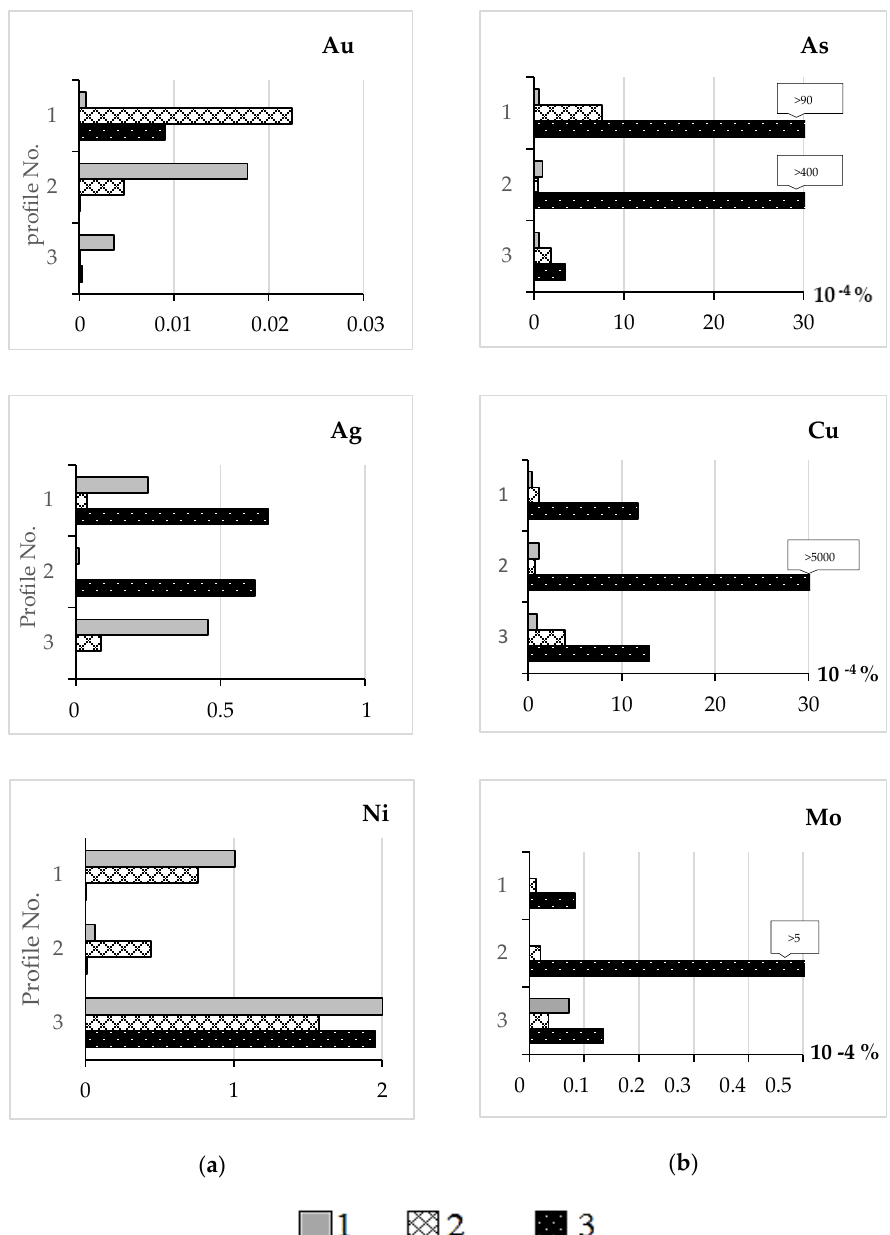
Figure 7. Ratio variation of elements to HA ( a ) and FA ( b ) carbon in soil at Novye Peski. Horizons: 1—E, 2—Bf, 3—C.